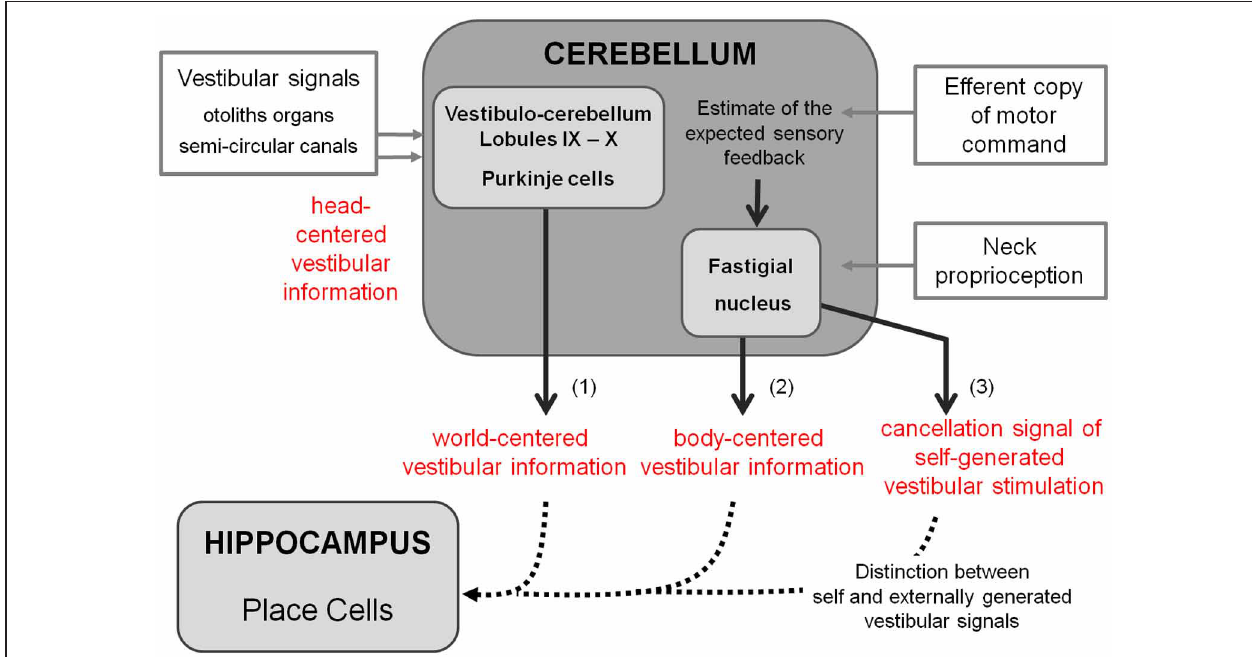
FIGURE 3 | Detailed cerebellar processing of self-motion information that can be used for building spatial representation. This figure represents the ascendant branch of Figure 1 and highlights the cerebellar contribution to building spatial representation. Based on the existing literature, cerebellar processing of self-motion information could involve three different computations: (1) The combination of otolith and semi-circular signals to convert head centered vestibular information into world centered vestibular information. (2) The integration of neck proprioceptive information with head motion vestibular information to compute an estimate of body